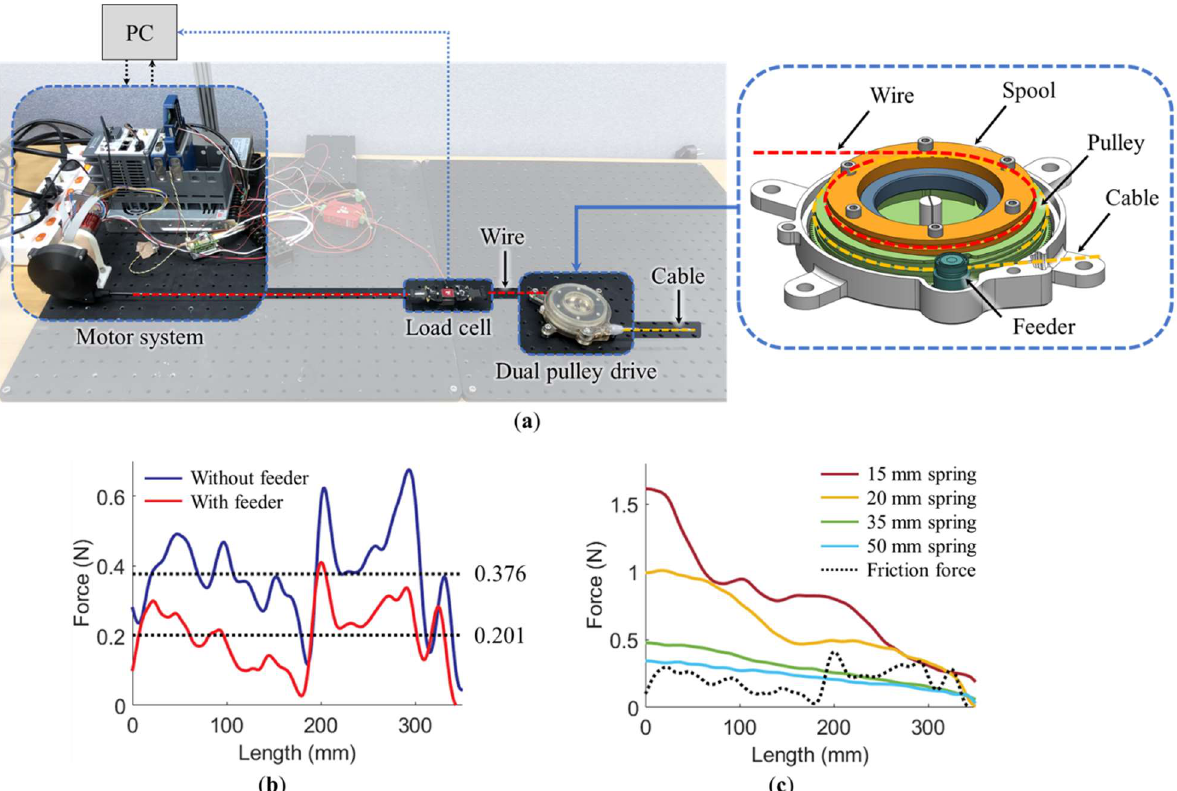
Figure 7. Tests conducted on the feeder mechanism and spring elasticity: ( a ) test bench for the feeder mechanism; ( b ) friction with and without the feeder; ( c ) spring elasticities of 15 mm, 20 mm, 35 mm, and 50 mm. A second-order Butterworth low-pass filter with a cutoff frequency of 0.2 Hz was used to obtain the data ( b , c ).